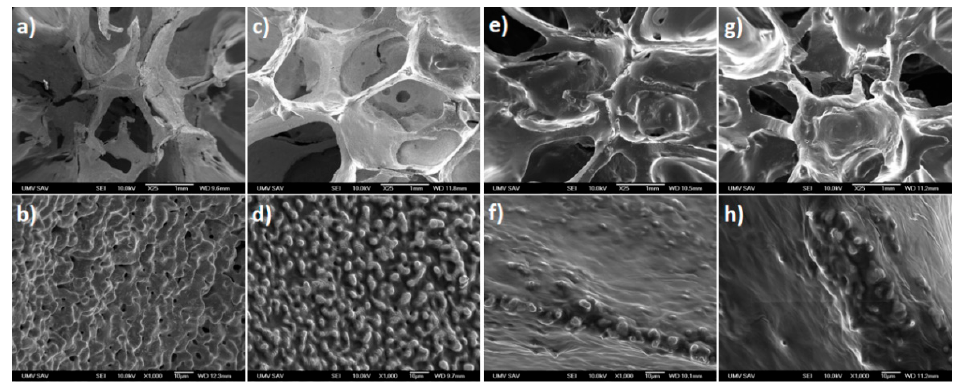
Figure 1. SEM micrographs of the surface of the open cell iron samples with a gradually increasing load of polyethylene glycol (PEG): Fe sample ( a , b ); Fe-PEG1, 0.8 wt. % PEG ( c , d ); Fe-PEG2, 1.5 wt. % PEG ( e , f ); and Fe-PEG3, 3.0 wt. % PEG ( g , h ). Details of the surfaces shown above at a higher magnification ( b , d , f , h ).